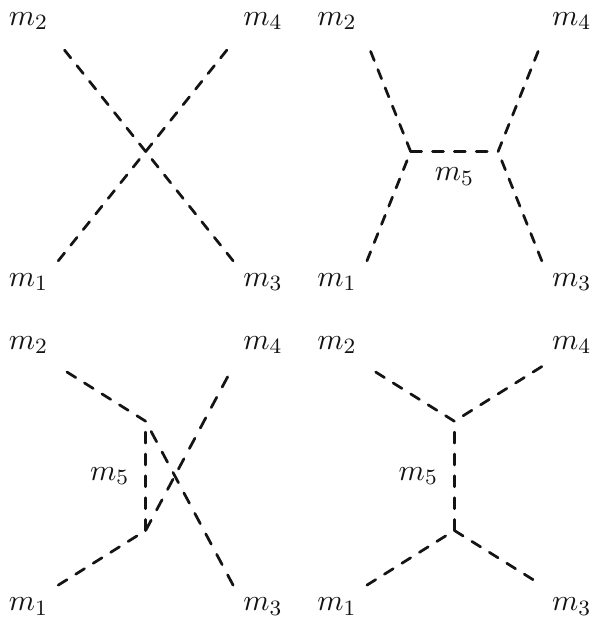
√ s (cid:8) m i , only the